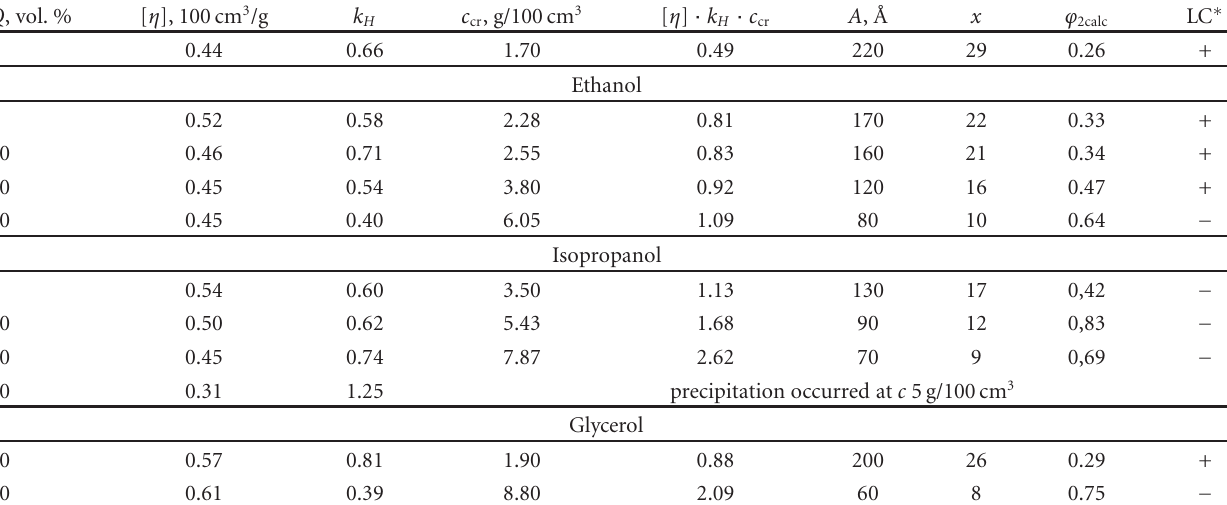
Table 6: Solvent composition e ff ect on the hydrodynamic characteristics and the parameters of thermodynamic polymer chain rigidity of Na-CAS in aqueous-alcoholic